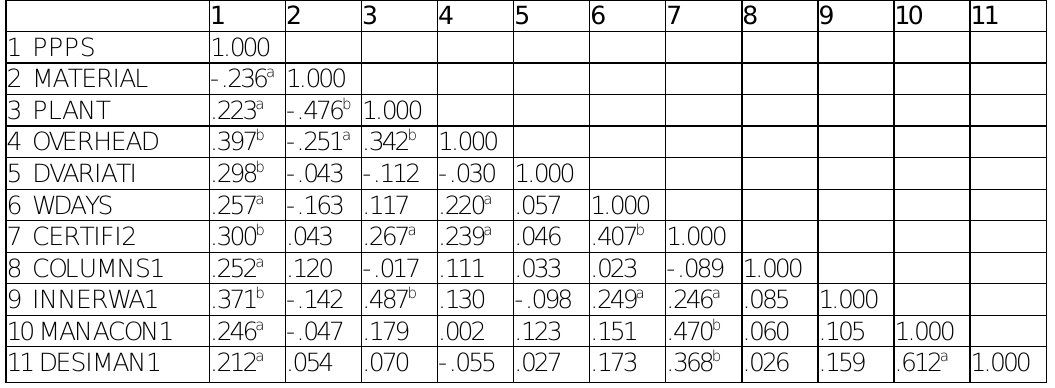
Table 2: Matrix of correlation for unit price in PPPs